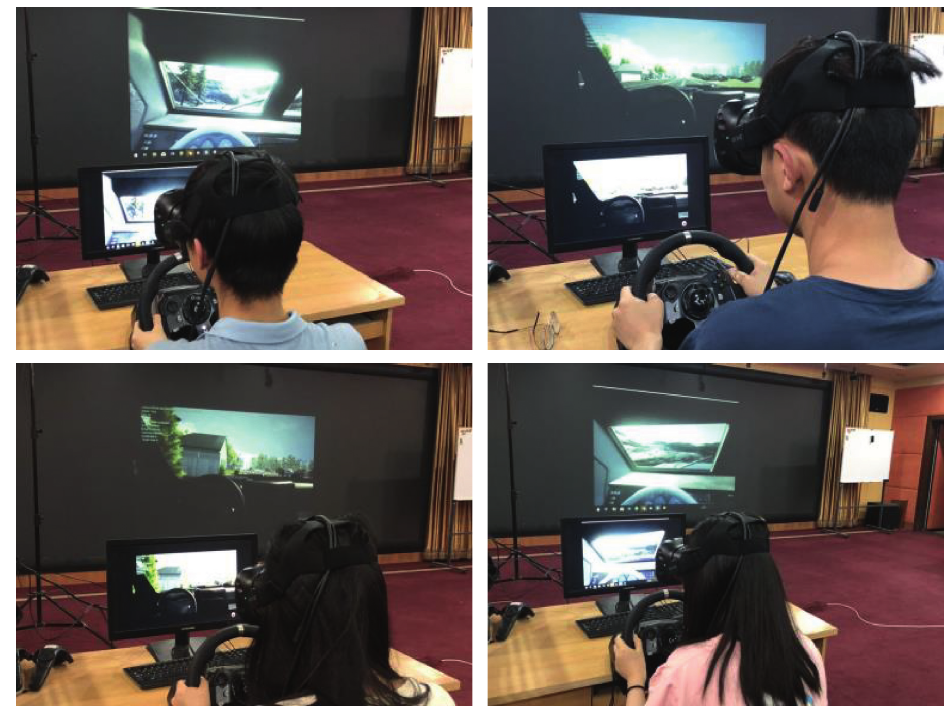
Figure 5: Driving